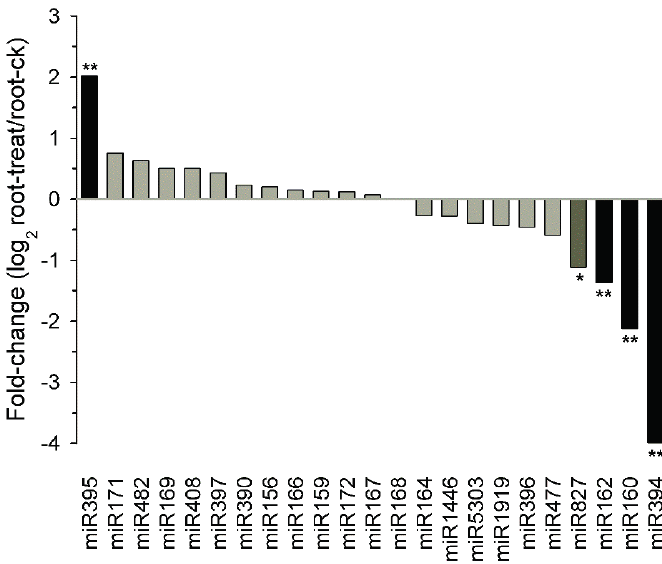
Figure 6. The expression profiles of the normalized sequence reads of the known miRNA families in the drought-treated library relative to the control library. * p -value < 0.01 is considered as significant; ** p -value < 0.001 is considered as extreme